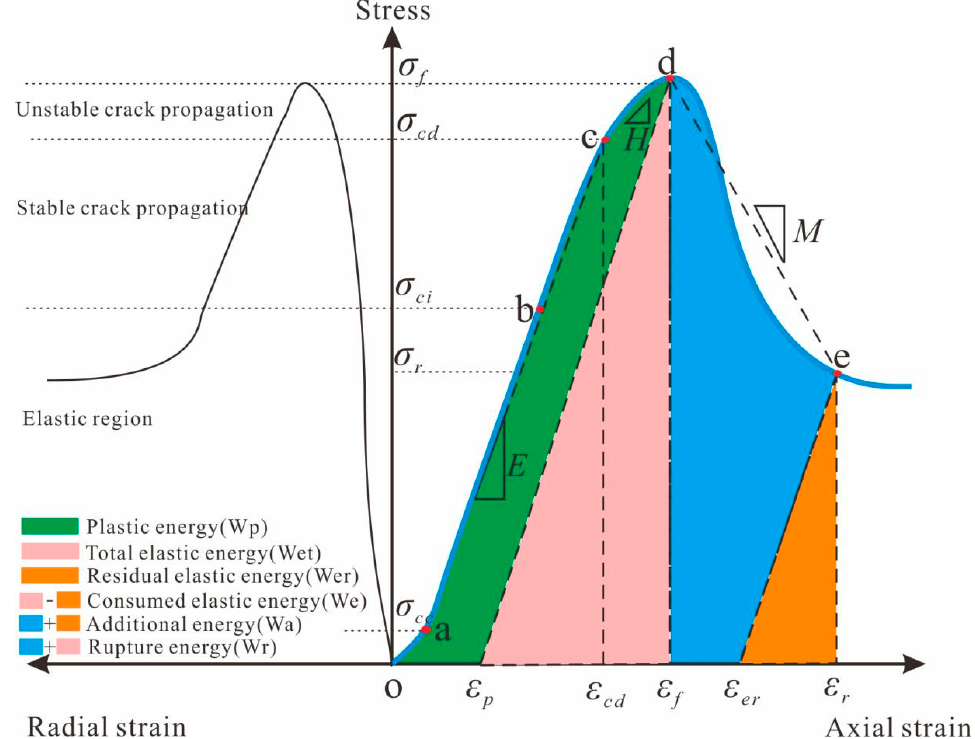
Figure 1. Typical compression stress-strain curve and associated deformation and failure characteristics for brittle rocks. σ cc : crack closure stress; σ ci : crack initiation stress; σ cd : crack damage stress; σ f : failure stress; σ r : residual stress; ε p : plastic strain; ε cd : strain at crack damage threshold; ε f : failure strain; ε r : residual strain; E : Young’s modulus; H : hardening modulus and M : drop modulus (modified from [17]).